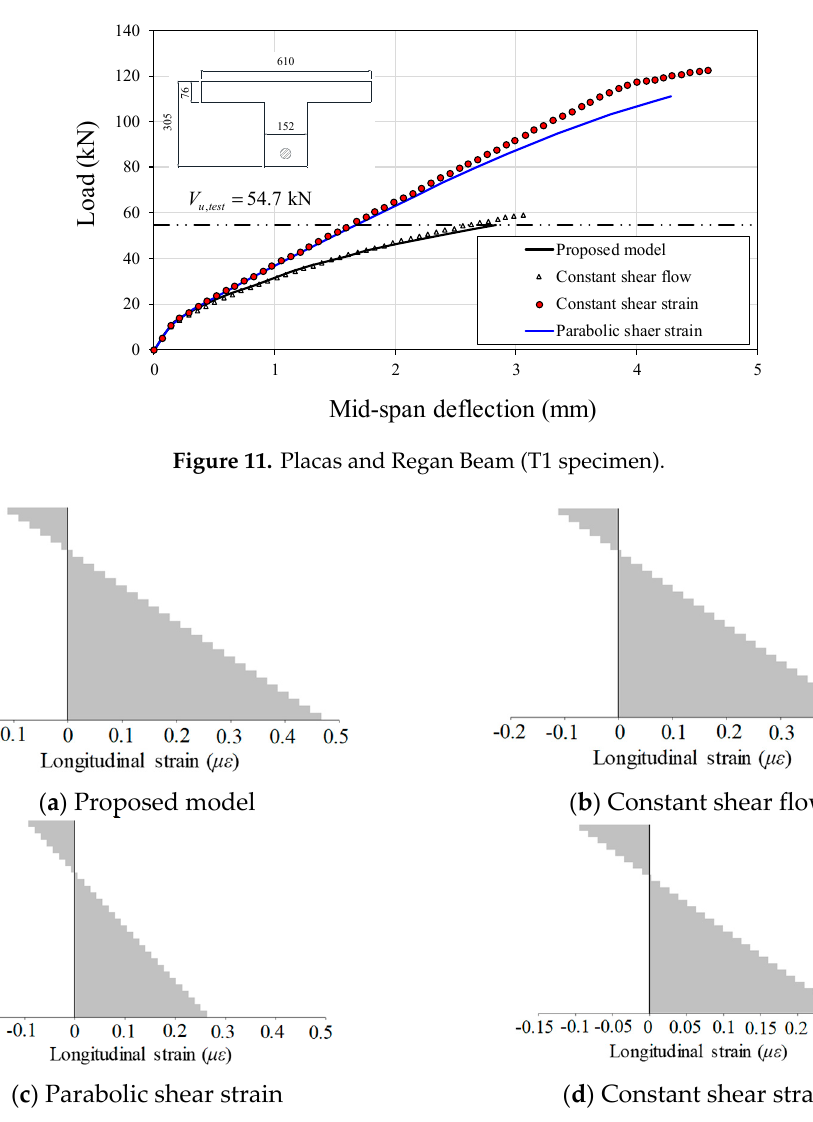
Figure 12. Longitudinal strain distribution over the cross section (at critical section, 54.7 kN V